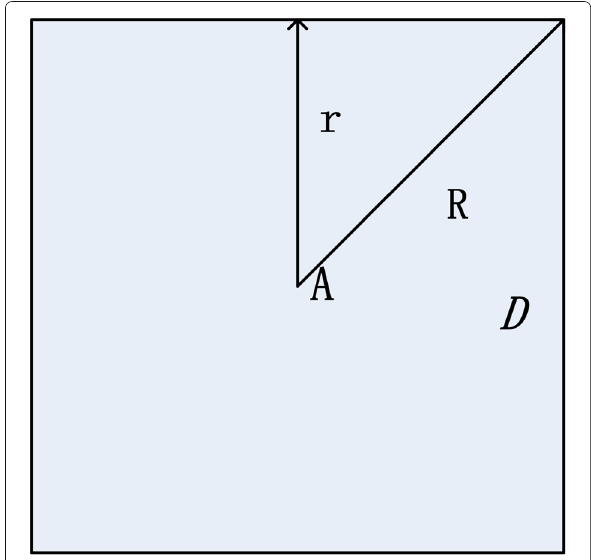
Fig. 2 The structure of cluster A. The relation between D and R is √ 2 R , where D denotes the length of cluster D =